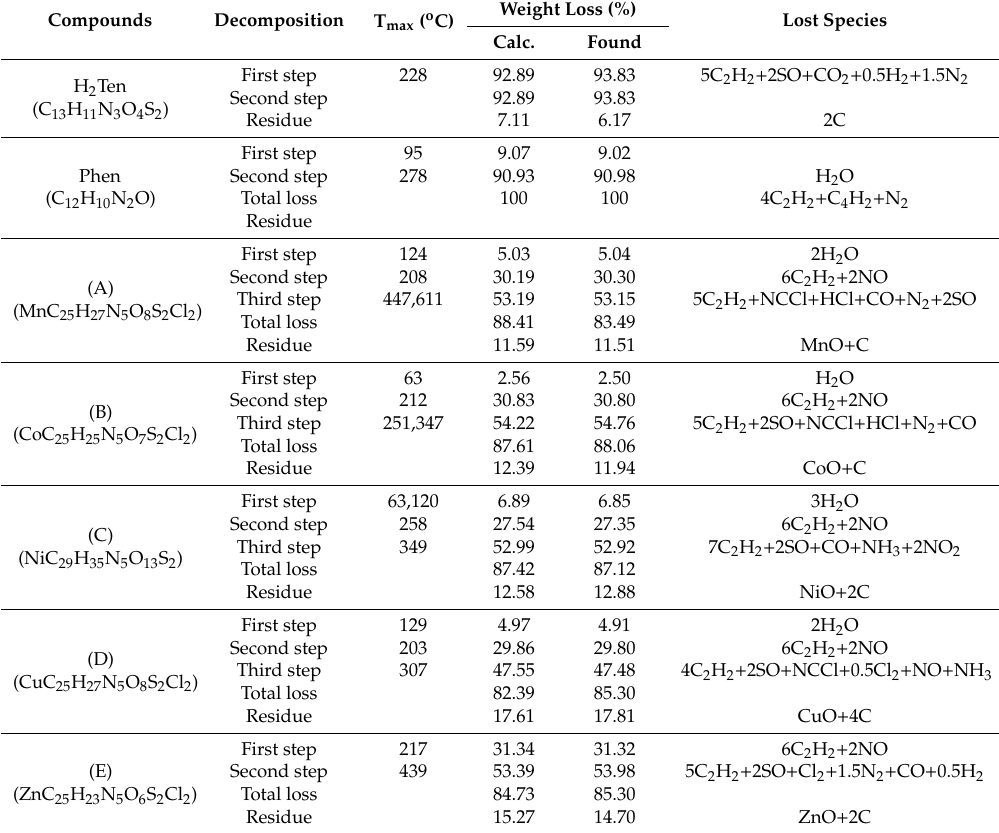
Table 3. The maximum temperature T max ( o C) and weight loss values of the decomposition stages for H 2 Ten, Phen and their metal